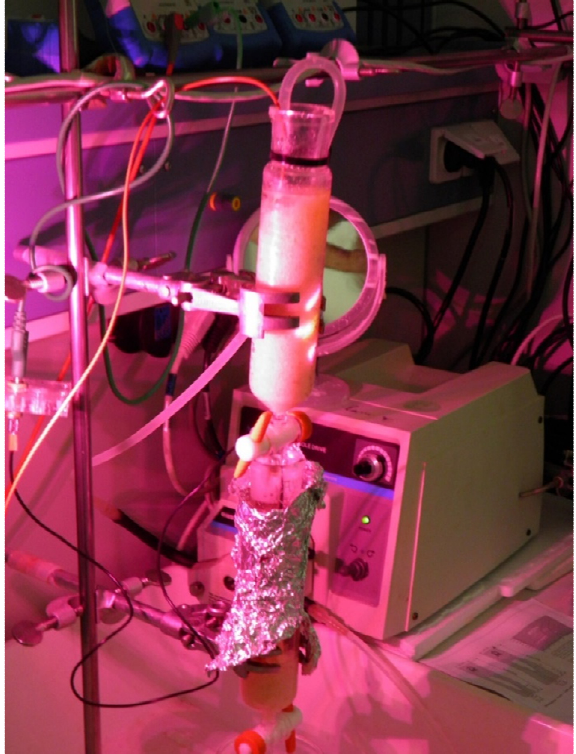
Figure 4. Illumination of the test system: Eu 2+ formed via photooxidation of glucose was passed down to the lower cavity with dripping water to give away the “extra” electrons to make ( a) H 2 and (b) a negative photocurrent. Illuminating the bottom cavity instead of the upper one produced no photocurrent whatsoever. A Becquerel effect was not observed with metal electrodes but only with illuminated semiconductive electrodes such as Se.